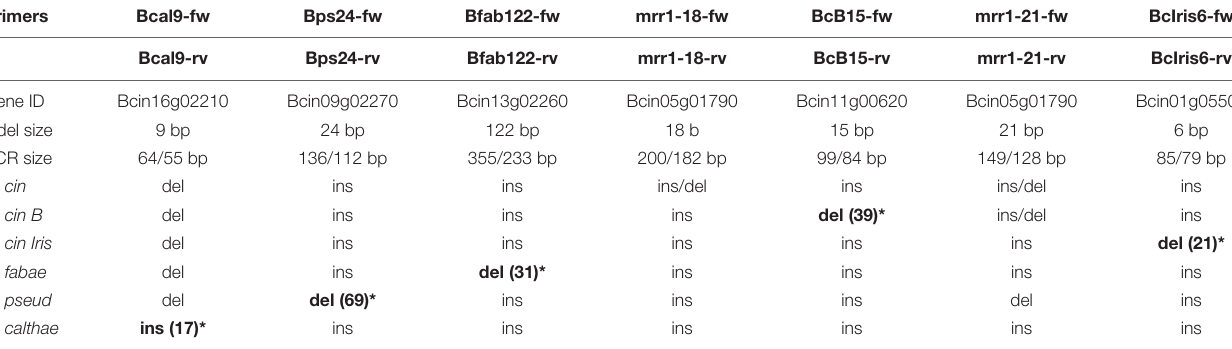
TABLE 4 | List of primers used for PCR-based differentiation of Botrytis species and genotypes of B. cinerea , depending on the insertion (ins) or deletion (del) state of diagnostic indels.